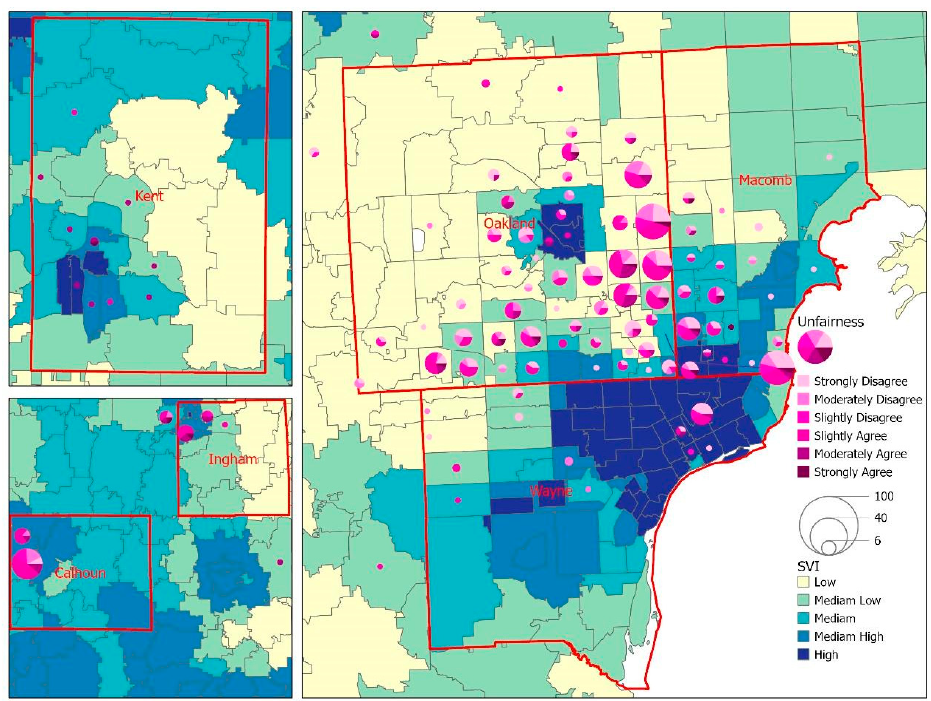
Figure 2. A map for the visualization of the overall SVI against the perception of unfairness due to race/ethnicity among survey respondents.